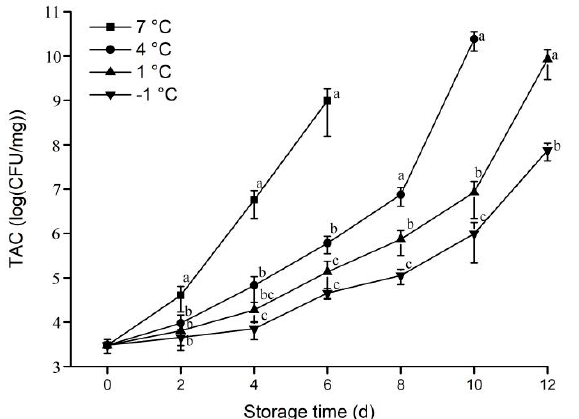
Figure 4. Effect of different storage temperatures on TAC of pork. Different lowercase letters (a − c) indicate significant difference ( p < 0.05) between each treatment on the same storage time .